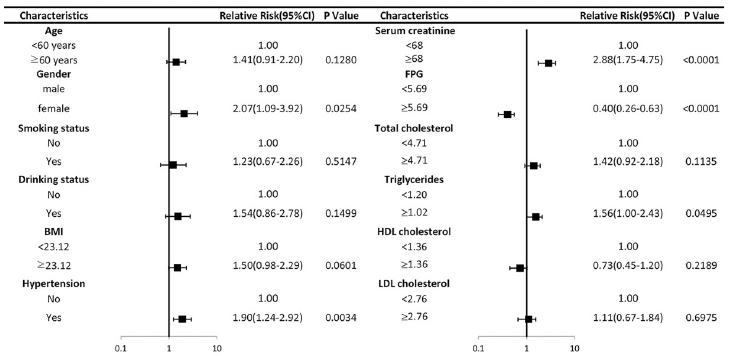
Fig 2. Forest plot of characteristics on relative risk and 95%CI of hyperuricemia in PSI population.